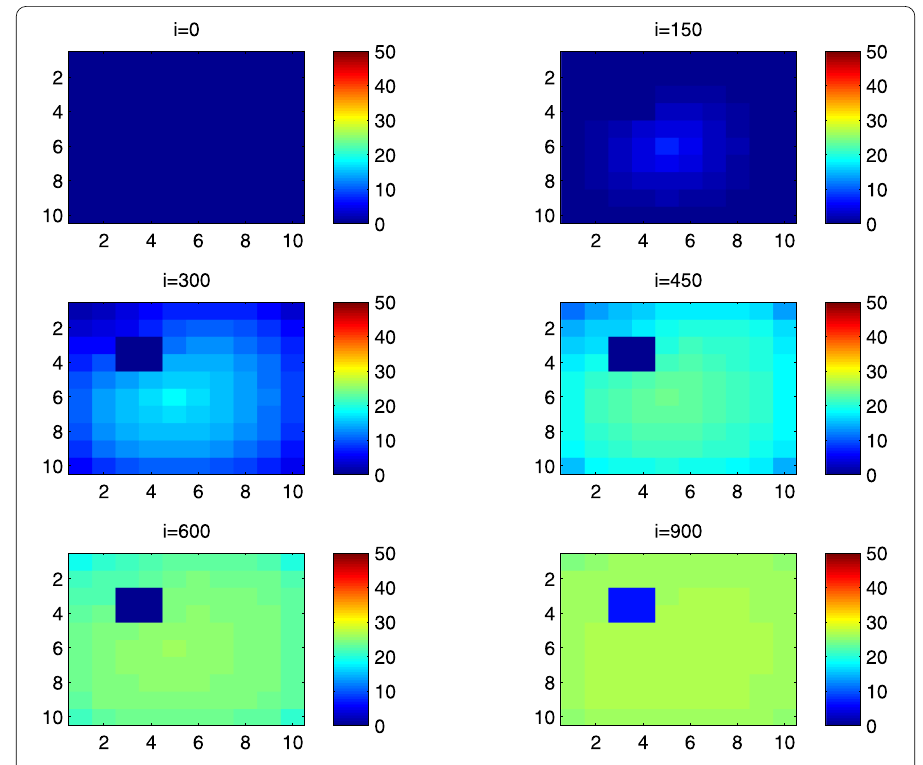
Figure 13 R Cpq behavior in the presence of optimal controls characterized in (11). The case when the disease starts from the center of (cid:2) .